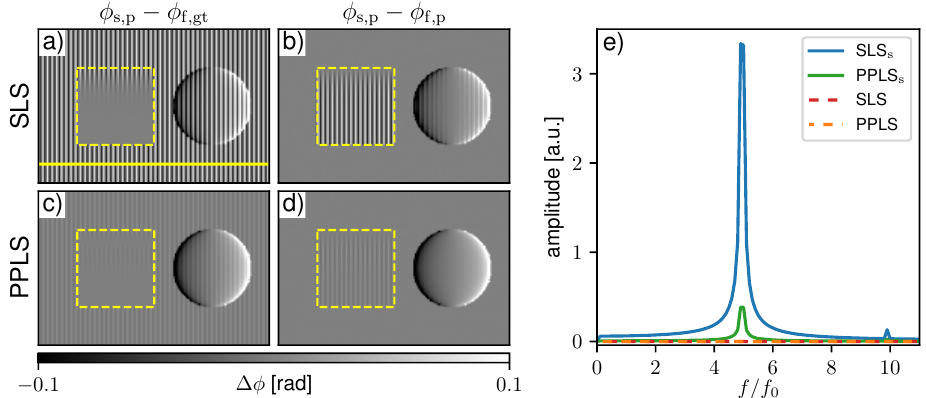
Figure 4. Comparison of processed differential-phase contrast (DPC) images with sinusoidal least square (SLS) and periodic polynomial least square (PPLS) fitting in case of precise phase steps. In ( a , c ) the sample image phase ( φ s,p ) is processed with the ground truth flat-field phase ( φ f,gt ) to visualize sampling artifacts for the SLS and PPLS respectively. In ( b , d ) the DPC images are processed with fitted flat-field phase ( φ f,p ), respectively. The yellow dashed squares mark the region with a scatter wedge with increasing scattering strength from top to bottom. Note that the images are windowed narrowly to visualize the fringe artifacts. ( e ) Corresponding Fourier spectra generated along the yellow line in ( a